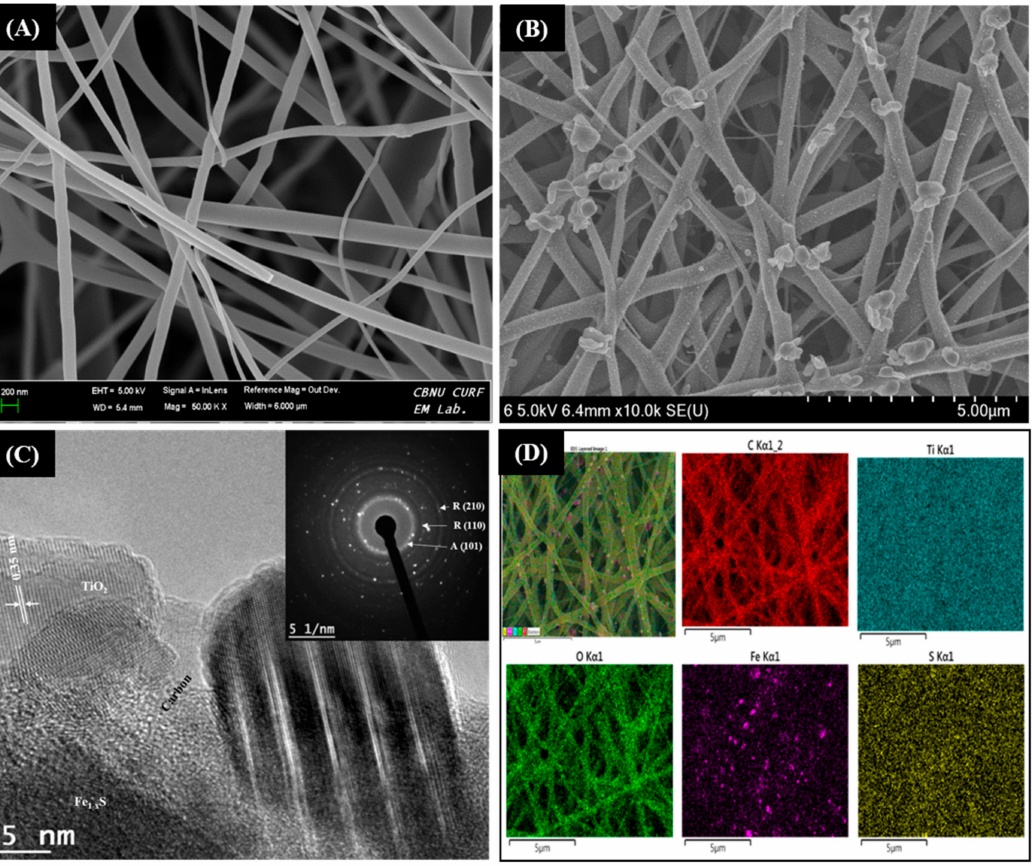
Figure 2. FE-SEM images of pristine TiO 2 NFs ( A ) and Fe 1 − x S-TiO 2 / CNFs composite ( B ). ( C) and ( D) are the TEM image and elemental mapping of the Fe 1 − x S-TiO 2 -CNFs composite, respectively. The inset of ( C ) represents the SAED